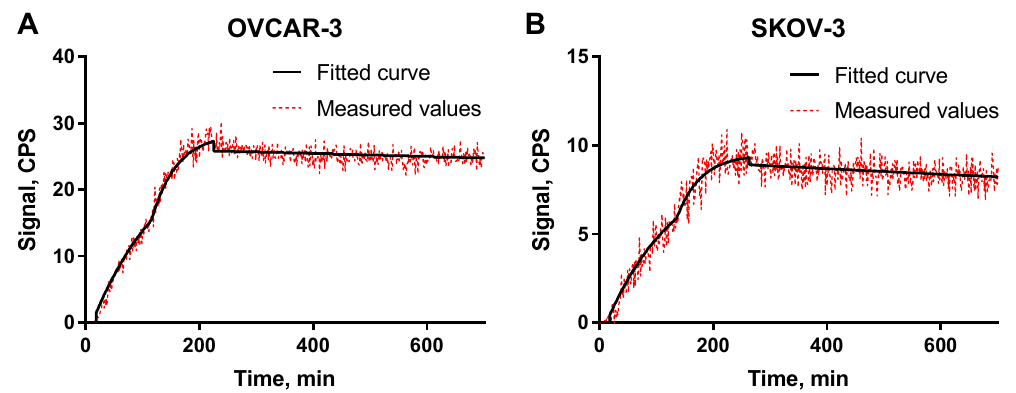
Figure 3. LigandTracer sensorgrams of [ 125 I]I-PIB-Ec1 binding to ( A ) OVCAR-3 cells and to ( B ) SKOV-3 cells. The association was measured at 3 and 9 nM concentrations. Table 1. Dissociation equilibrium constants (K D ) for the interaction between [ 125 I]I-PIB-Ec1 and OVCAR-3 and SKOV-3 cells.